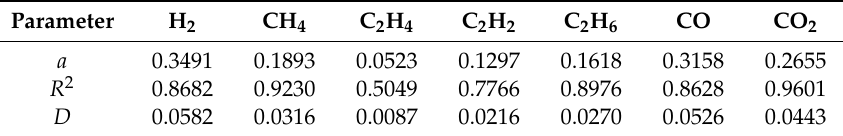
Table 6. Diffusion coefficients of gas molecules in cellulose (Å 2 /s)